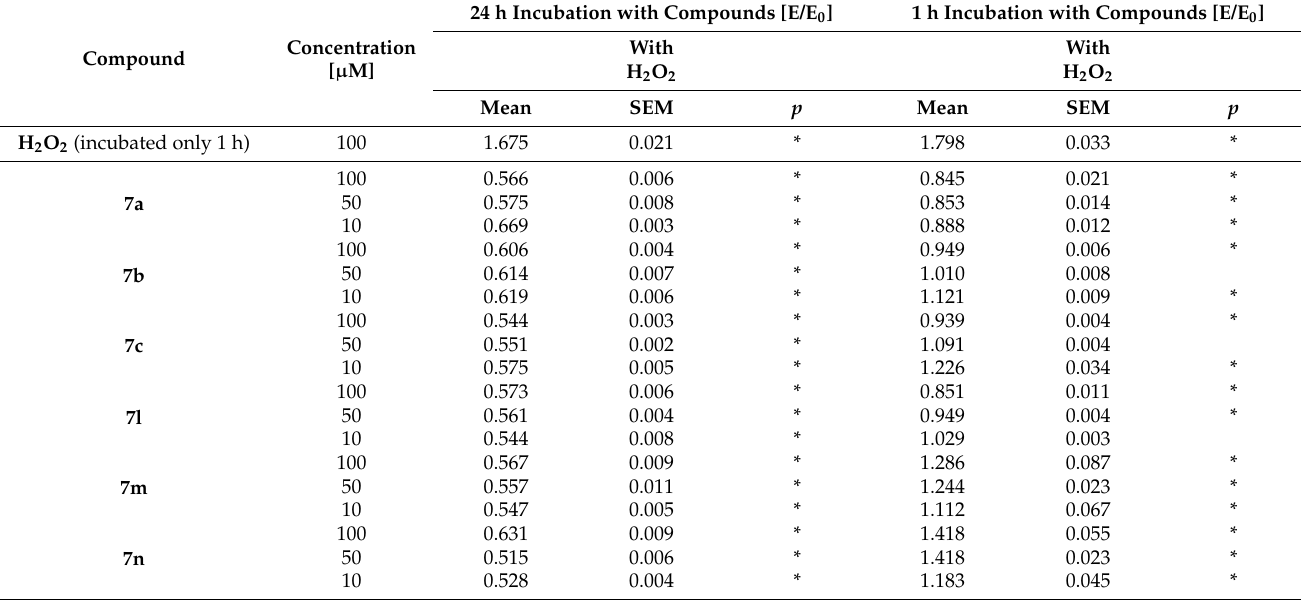
Table 4. ROS scavenging activity of compounds [mean (SD); n = 5]; the results were compared to the control and expressed as E/E0 ratios; statistical significance calculated with post hoc test compared to the control (* p < 0,05; E0—cultures without tested